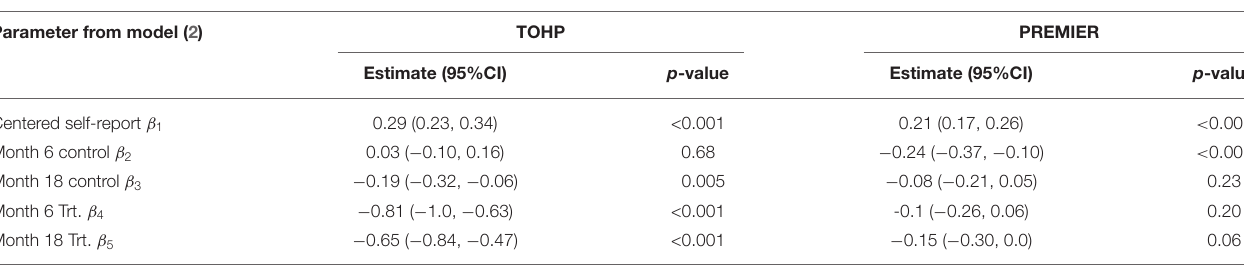
TABLE 2 | Standardized regression output from the final regression model. Parameter from model (2)